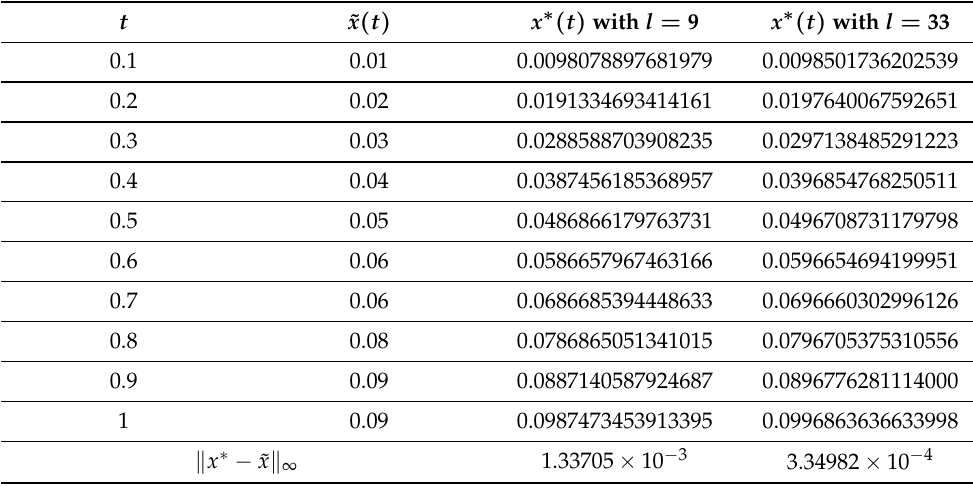
Table 5. Numerical results for (19) with initial x 0 ( t ) = 1/2 cos ( 10 π t )